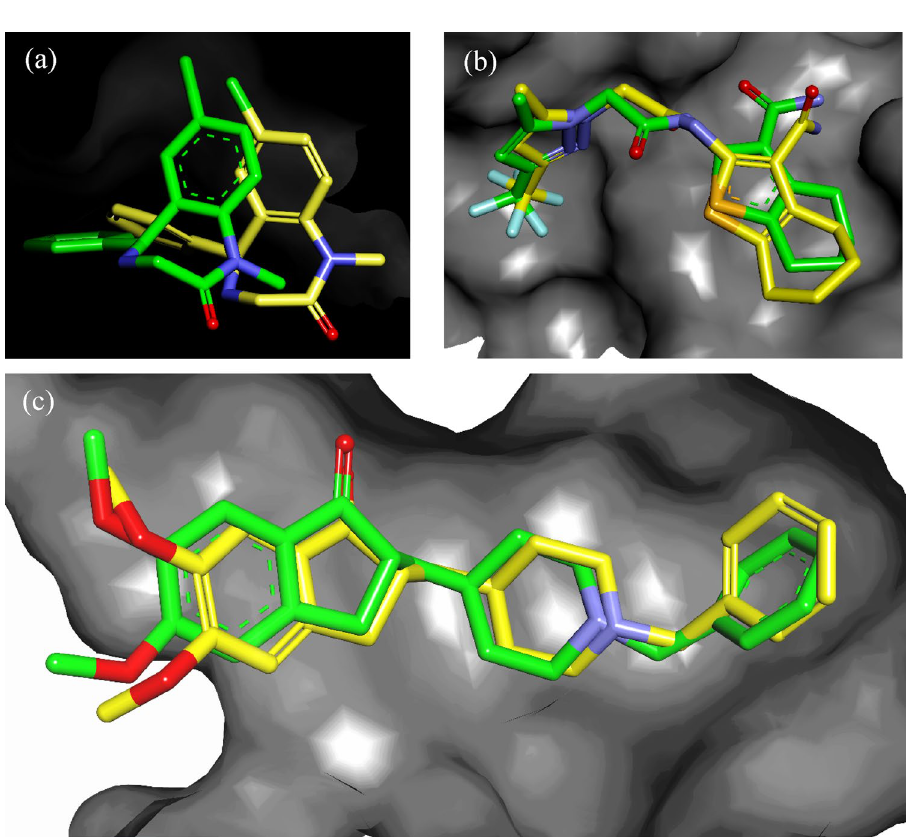
Figure 5. Overlapped poses of co-crystalized ligand (in green) and docked pose of same ligand (in yellow) in ( a ) GABA receptor (PDB code: 6X3X), ( b ) AMPA receptor (PDB code: 5YBF) and ( c ) AChE enzyme (PDB code: 1EVE) with their co-crystallized ligand i.e., Diazepam, HBT-1, Donepezil